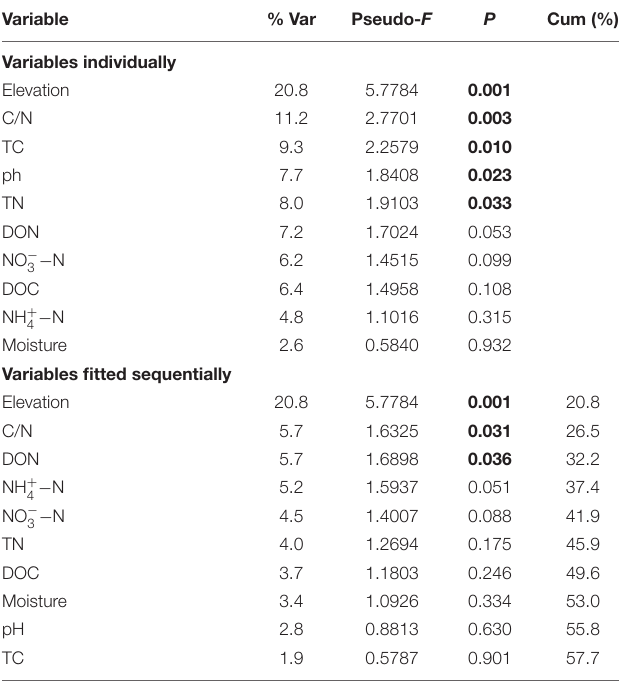
P = 0.005). Within the alpine tundra of Changbai Mountain,